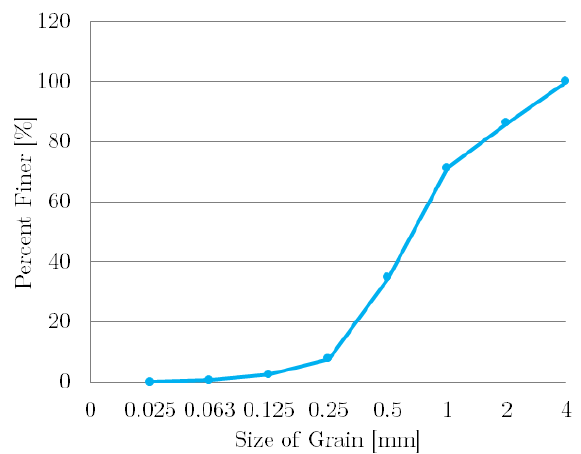
Figure 4. Grain curve of sand.